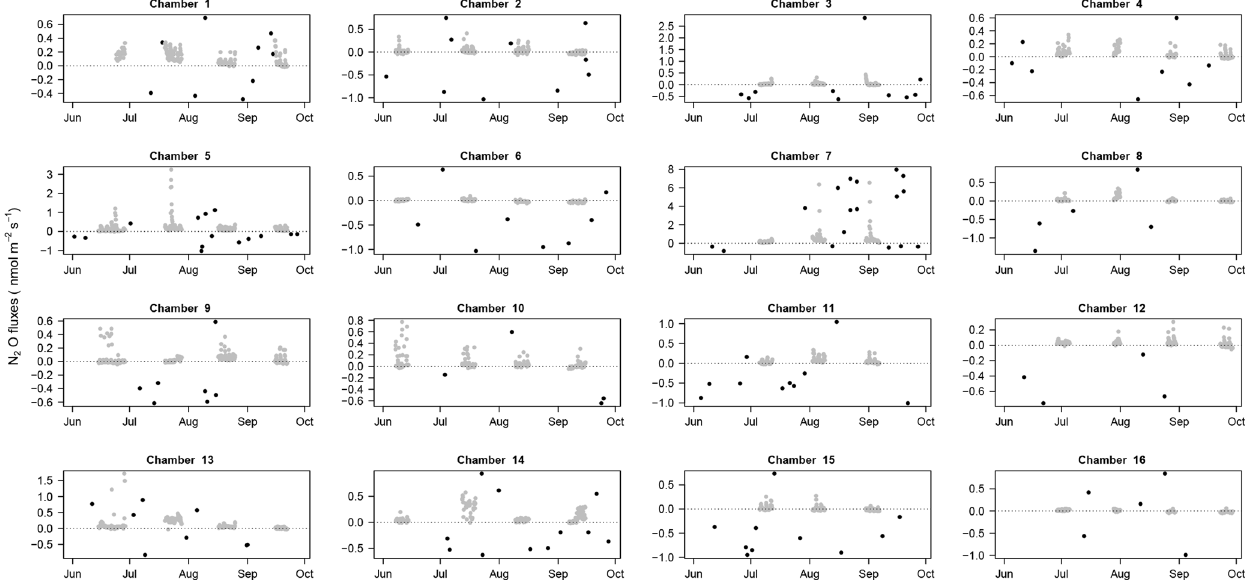
Figure 7. N 2 O fluxes through time: N 2 O fluxes for each chamber (1 to 16) over the study period with fluxes estimated with the SHORT (2min) closure time in black and fluxes estimated with the LONG (25min) closure time in grey. The dotted line displays the zero flux line. Due to the high differences among chambers, each panel has a specific limit on the y